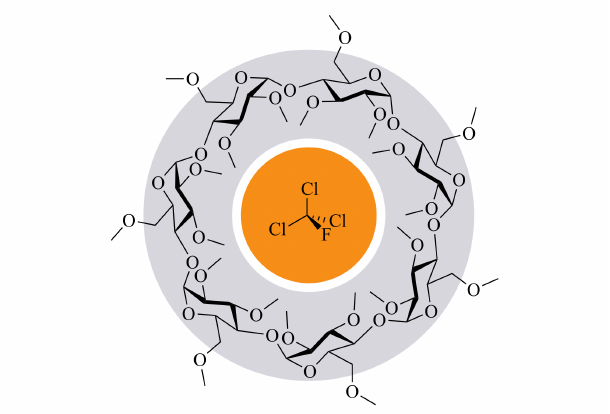
Figure 2. Illustration of the inclusion complex formation of trichlorofluoromethane (inner orange circle) in heptakis(2,3,6-tri- O -methyl)- β -cyclodextrin (outer gray